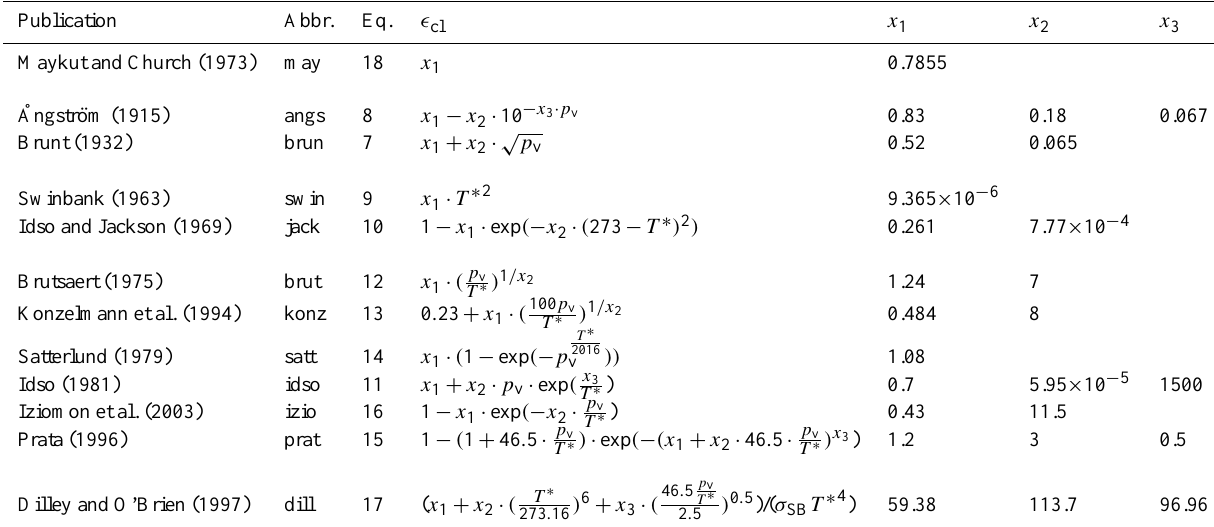
Table 3. Parameterizations of clear-sky emissivity. p v is the water vapor pressure [hPa], and T ∗ the measured temperature [K]. x 1 ,x 2 and x 3 denote the empirical